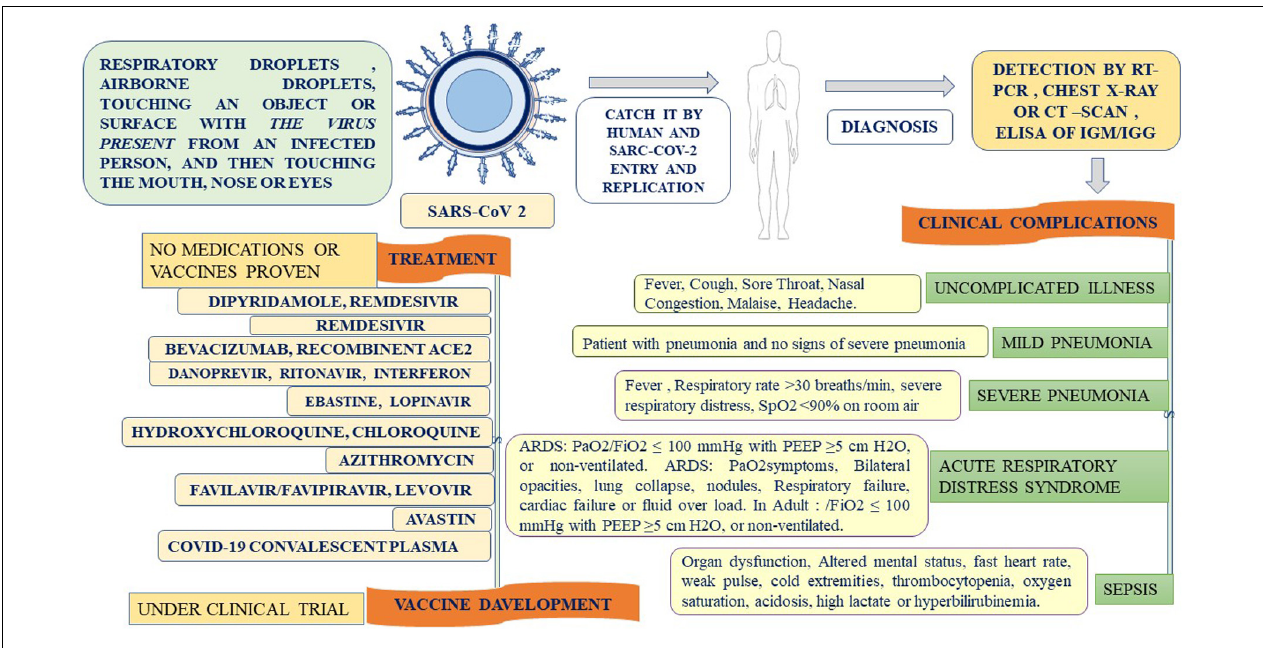
FIGURE 3 | Flow diagram for diagnosis, clinical presentation, and treatment of